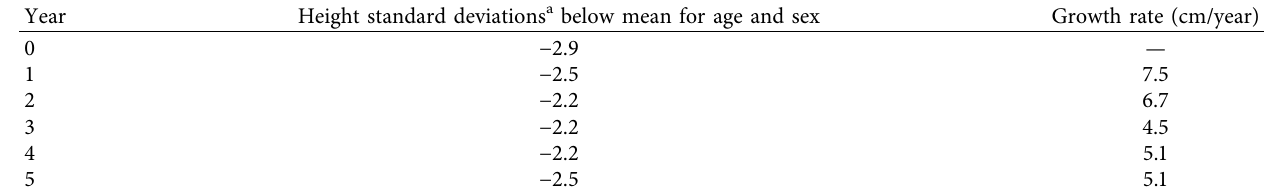
Table 2: Annual growth parameters.